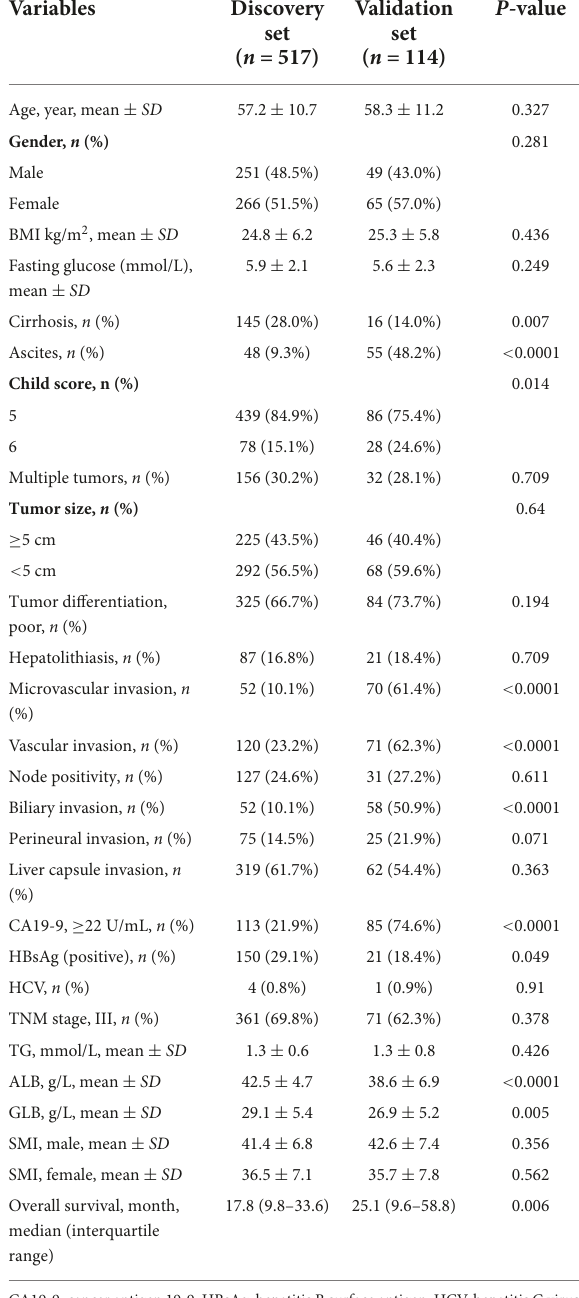
TABLE 1 Baseline characteristics of